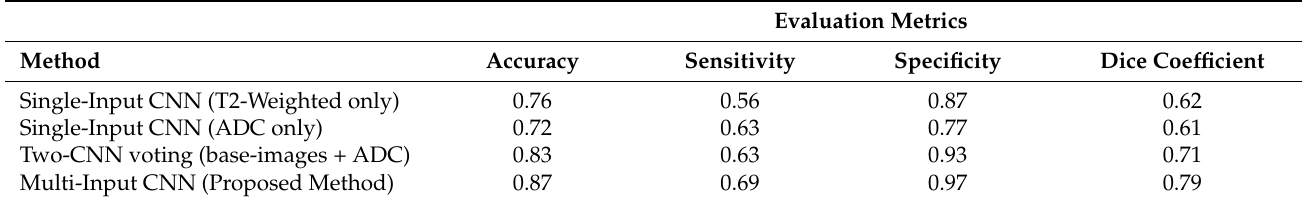
Table 5. Ablation study results for the proposed